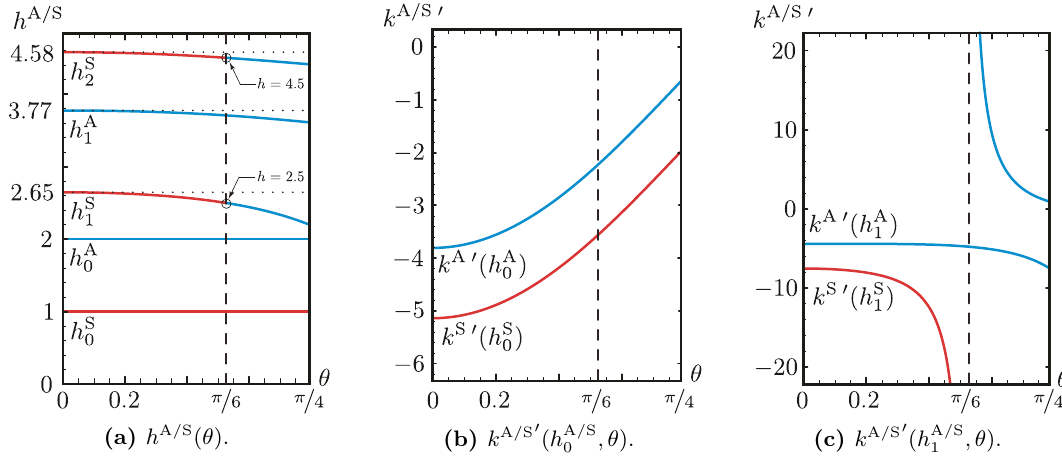
Figure 12. We set (cid:1) = 1 = 4 for all plots in this (cid:12)gure. (a) Plots of h A ( (cid:18) ) and h S ( (cid:18) ) as functions of (cid:18) . All dimensions h S for k > 1 disappear at (cid:18) = (cid:25)= 6 and reappear in the anti-symmetric k branch. (b) Plots of k A 0 (2 ; (cid:18) ) and k S 0 (1 ; (cid:18) ) (derivative w.r.t. h , not (cid:18) ) as functions of (cid:18) . Note that k S 0 (1 ; (cid:18) ) = (cid:0) (1 (cid:0) 2(cid:1)) (cid:0) 1 (cid:0) (cid:25) cos(2 (cid:18) ) = cos(2 (cid:25) (cid:1)) (for an arbitrary (cid:1)) is denoted by k 0 (1) in eq. (3.27). (c) Plots of k A 0 ( h A ; (cid:18) ) and k S 0 ( h S ; (cid:18) ) as functions of (cid:18) . Note k S 0 ( h S ; (cid:18) ) ! (cid:0)1 as (cid:18) 1 1 1 approaches the critical value (cid:25)= 6 from the left. For (cid:18) slightly above (cid:25)= 6, the solution reappears in the anti-symmetric branch with a divergent (+ 1 ) derivative k A 0